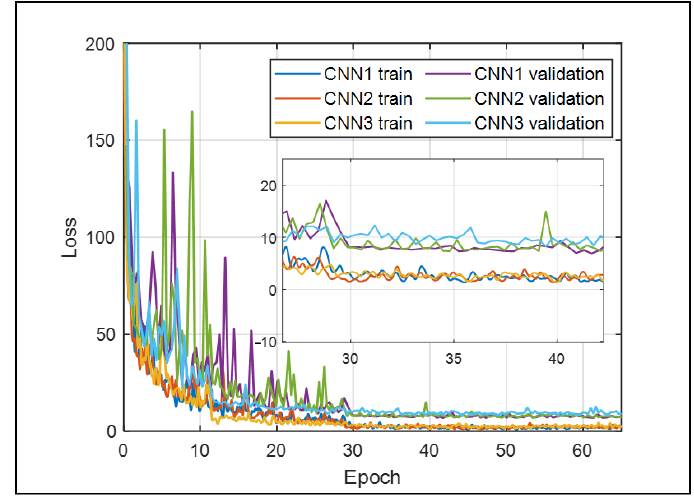
Figure 4. Loss curves of the training stage.